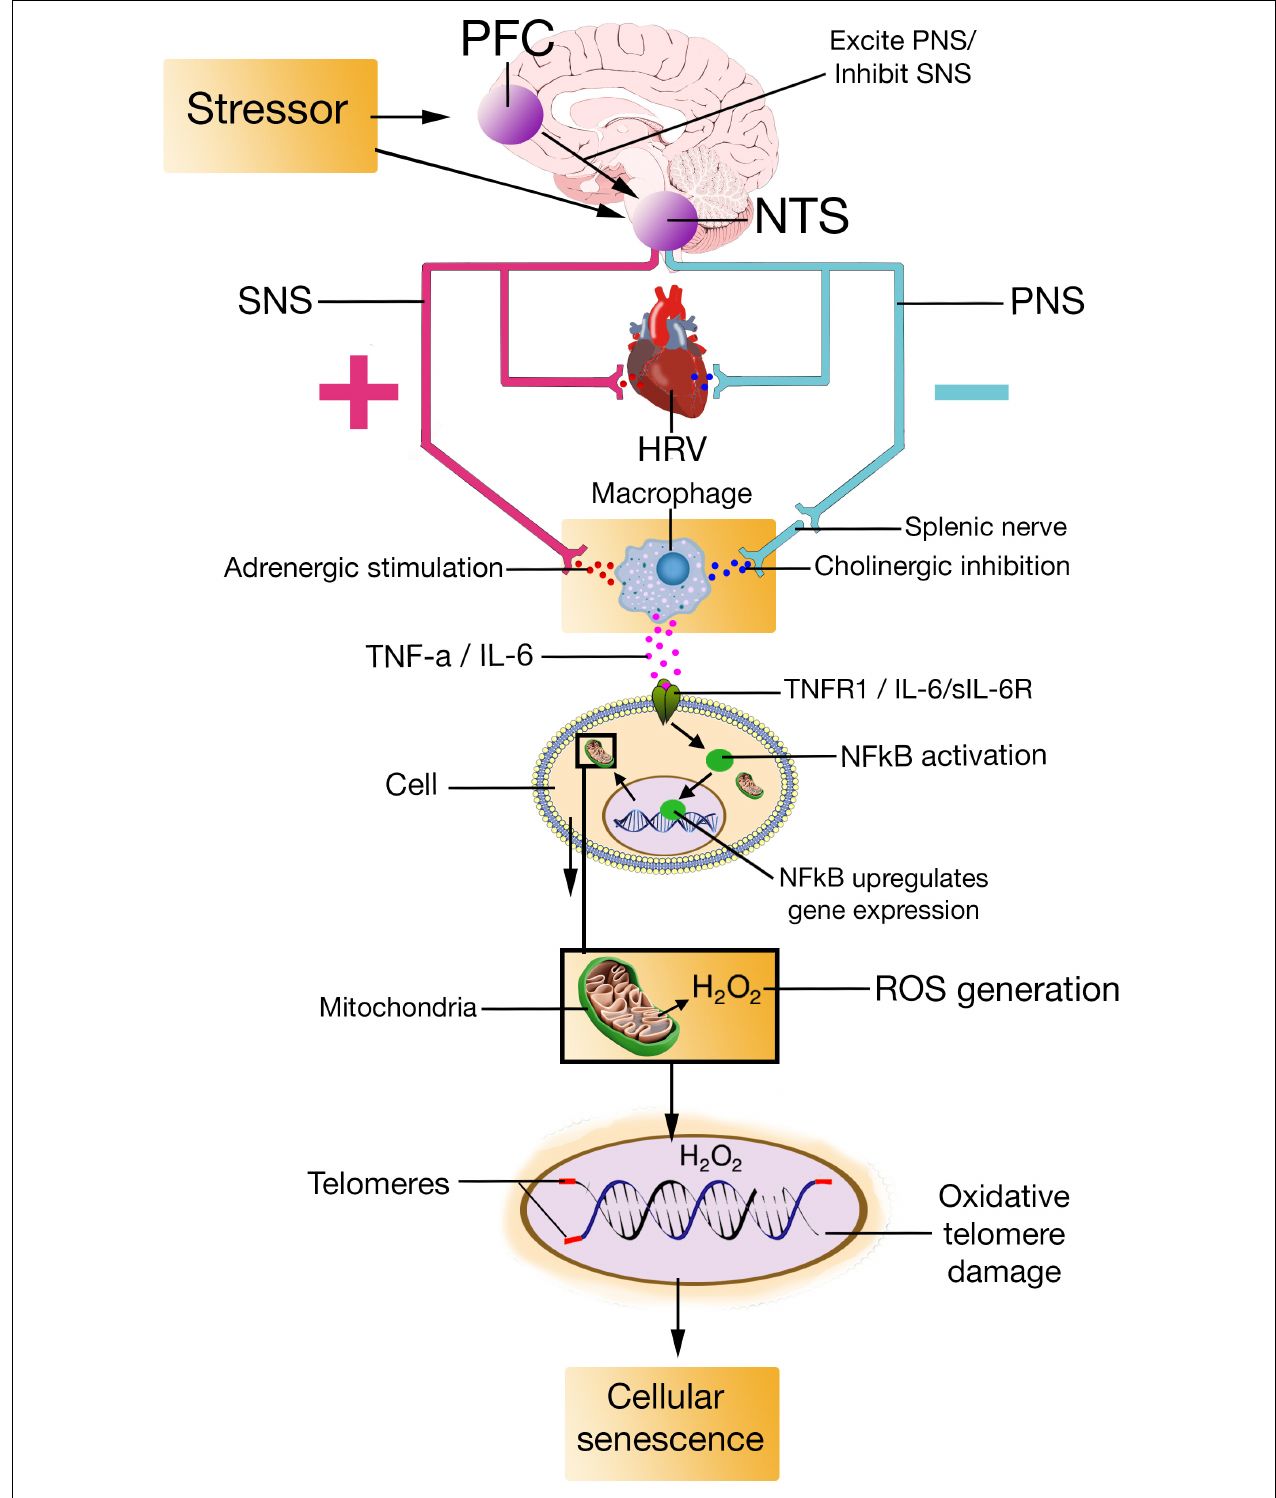
FIGURE 1 | PFC, prefrontal cortex; NTS, nucleus of the tractus solitarius; SNS, sympathetic nervous system; PNS, parasympathetic nervous system; HRV, heart rate variability; TNF-a, Tumor Necrosis Factor-alpha; IL-6, interleukin-6; TNFR1, Tumor Necrosis Factor-alpha Receptor 1; sIL-6R, soluble interleukin-6 receptor; NFkB, Nuclear factor kappa light chain enhancer of activated B cells; H2O2, hydrogen peroxide; ROS, reactive oxygen species.